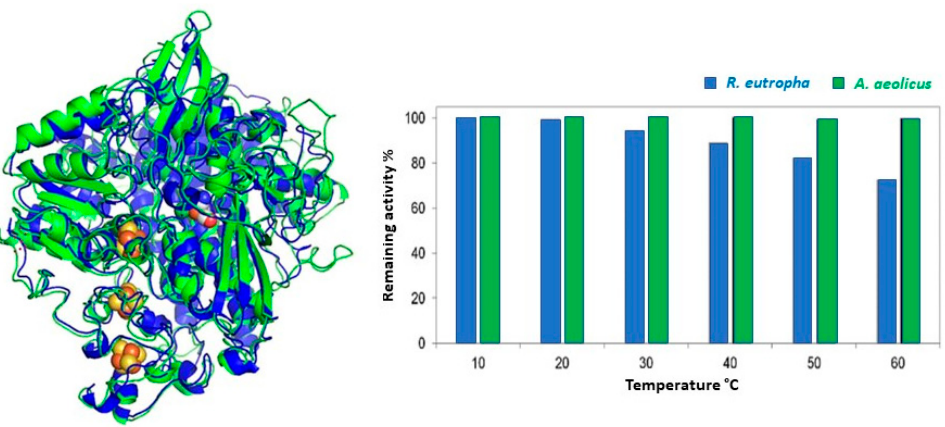
Figure 7. A. aeolicus and R. eutropha are two homologous NiFe HASEs with different thermostability. ( Left ) Structural alignment of mesophilic R. eutropha (blue) and hyperthermophilic A. aeolicus (green) HASEs, ( right ) remaining activity of the two HASEs after 360 s incubation at increasing temperatures. Adapted with permission from